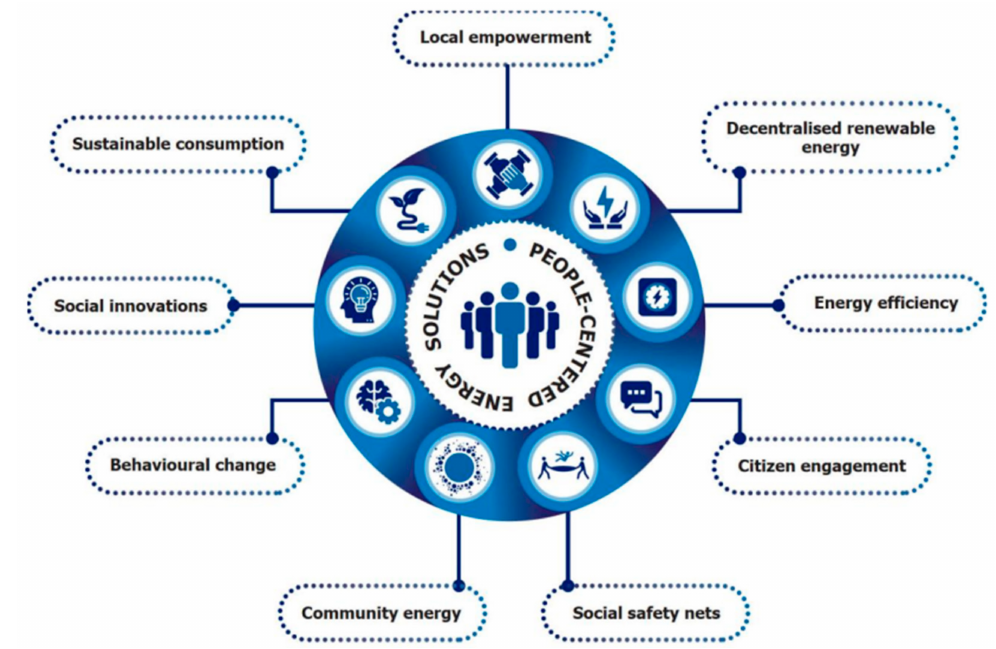
Figure 2. The role of people in bridging different elements of sustainable energy transitions